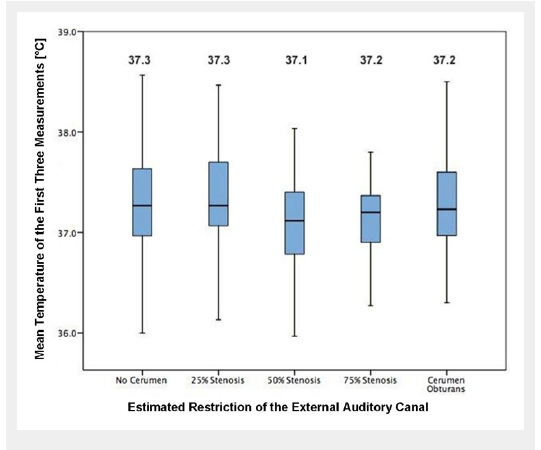
Effect of cerumen removal on mean temperature. Box contains 50% of the median values, Whiskers define 95%